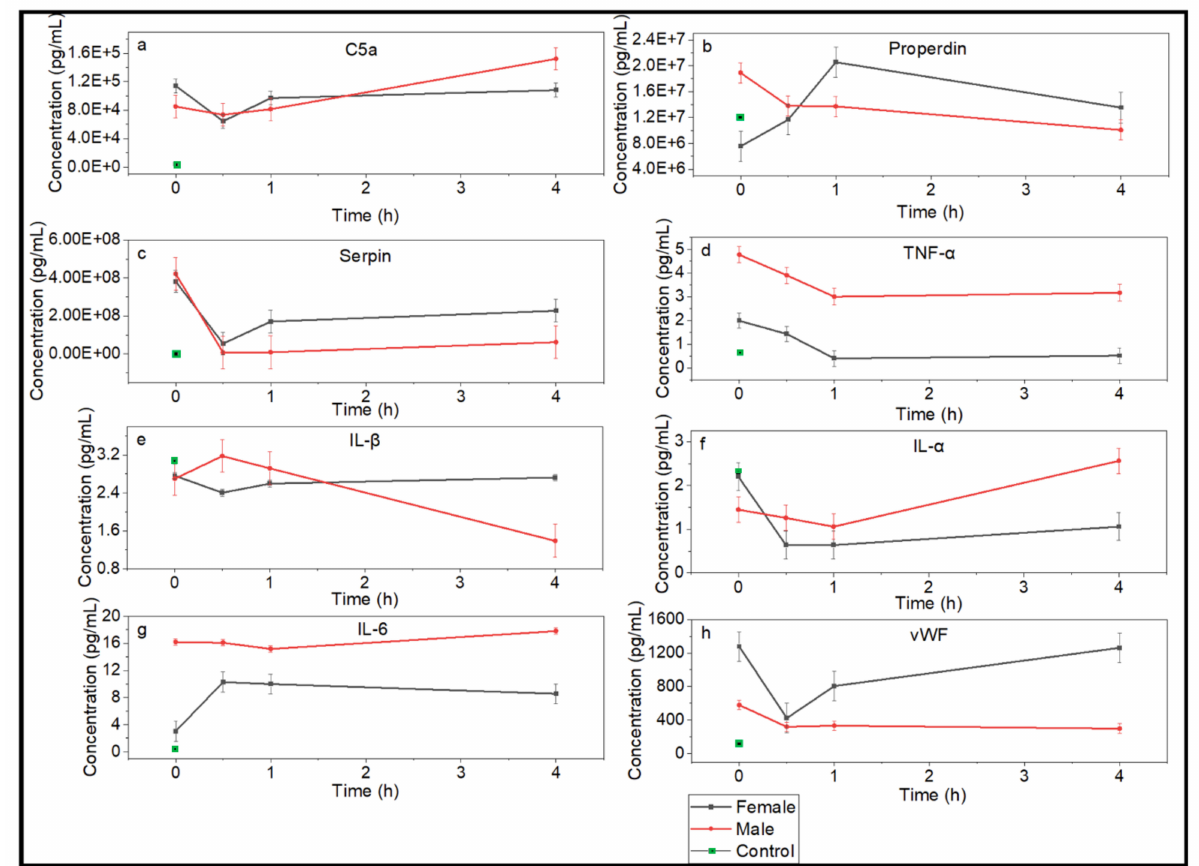
Figure 9. Concentrations of ( a ) C5a, ( b ) properdin, ( c ) serpin, ( d ) TNF- α , ( e ) IL-1 β , ( f ) IL-1 α , ( g ) IL-6, and ( h ) vWF in blood samples collected during dialysis session from female and male patients (Qb = 200 mL/min; Qd = 500